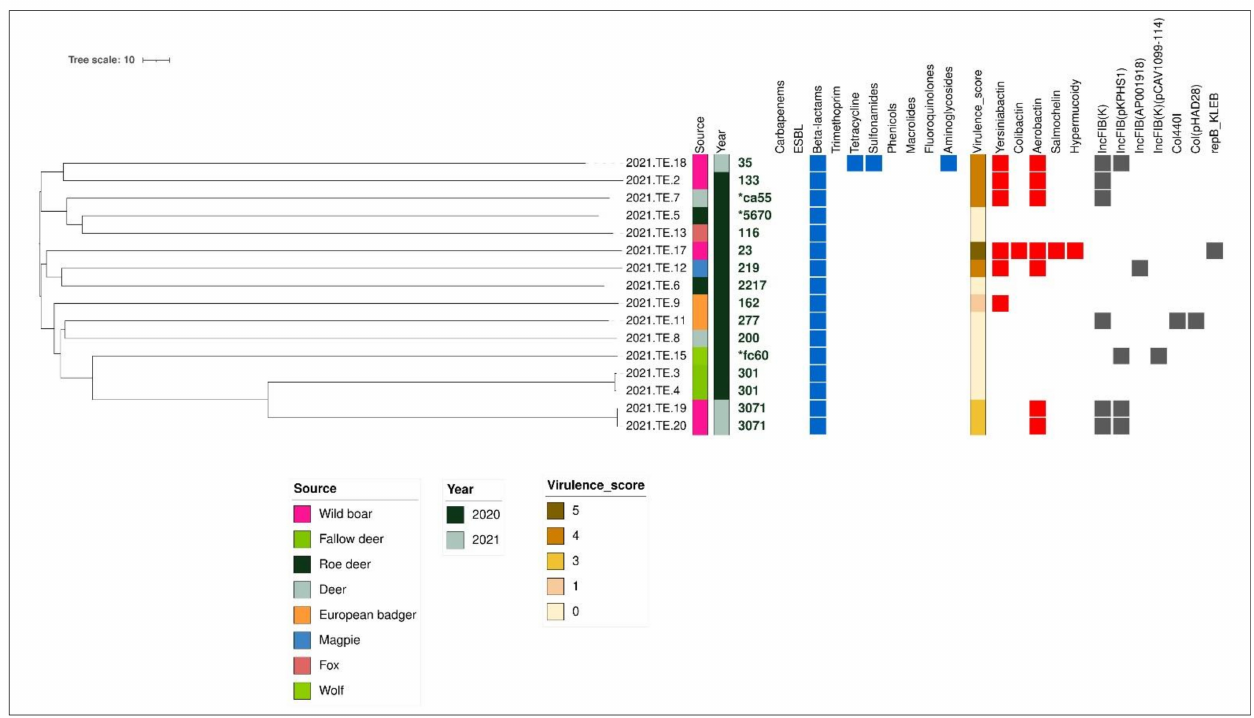
Figure 3. Neighbor joining (NJ) tree resulting from the cgMLST analysis performed on the 16 K. pneumoniae draft assemblies according to the Pasteur Institute’s scheme (629 loci). The tree is annotated with metadata (source and year of isolation), antimicrobial resistance gene (blue color indi- cates the presence), virulence score, virulence genes (red color indicates the presence), and plasmid (grey color indicates the presence). For novel sequence types we attributed the symbol